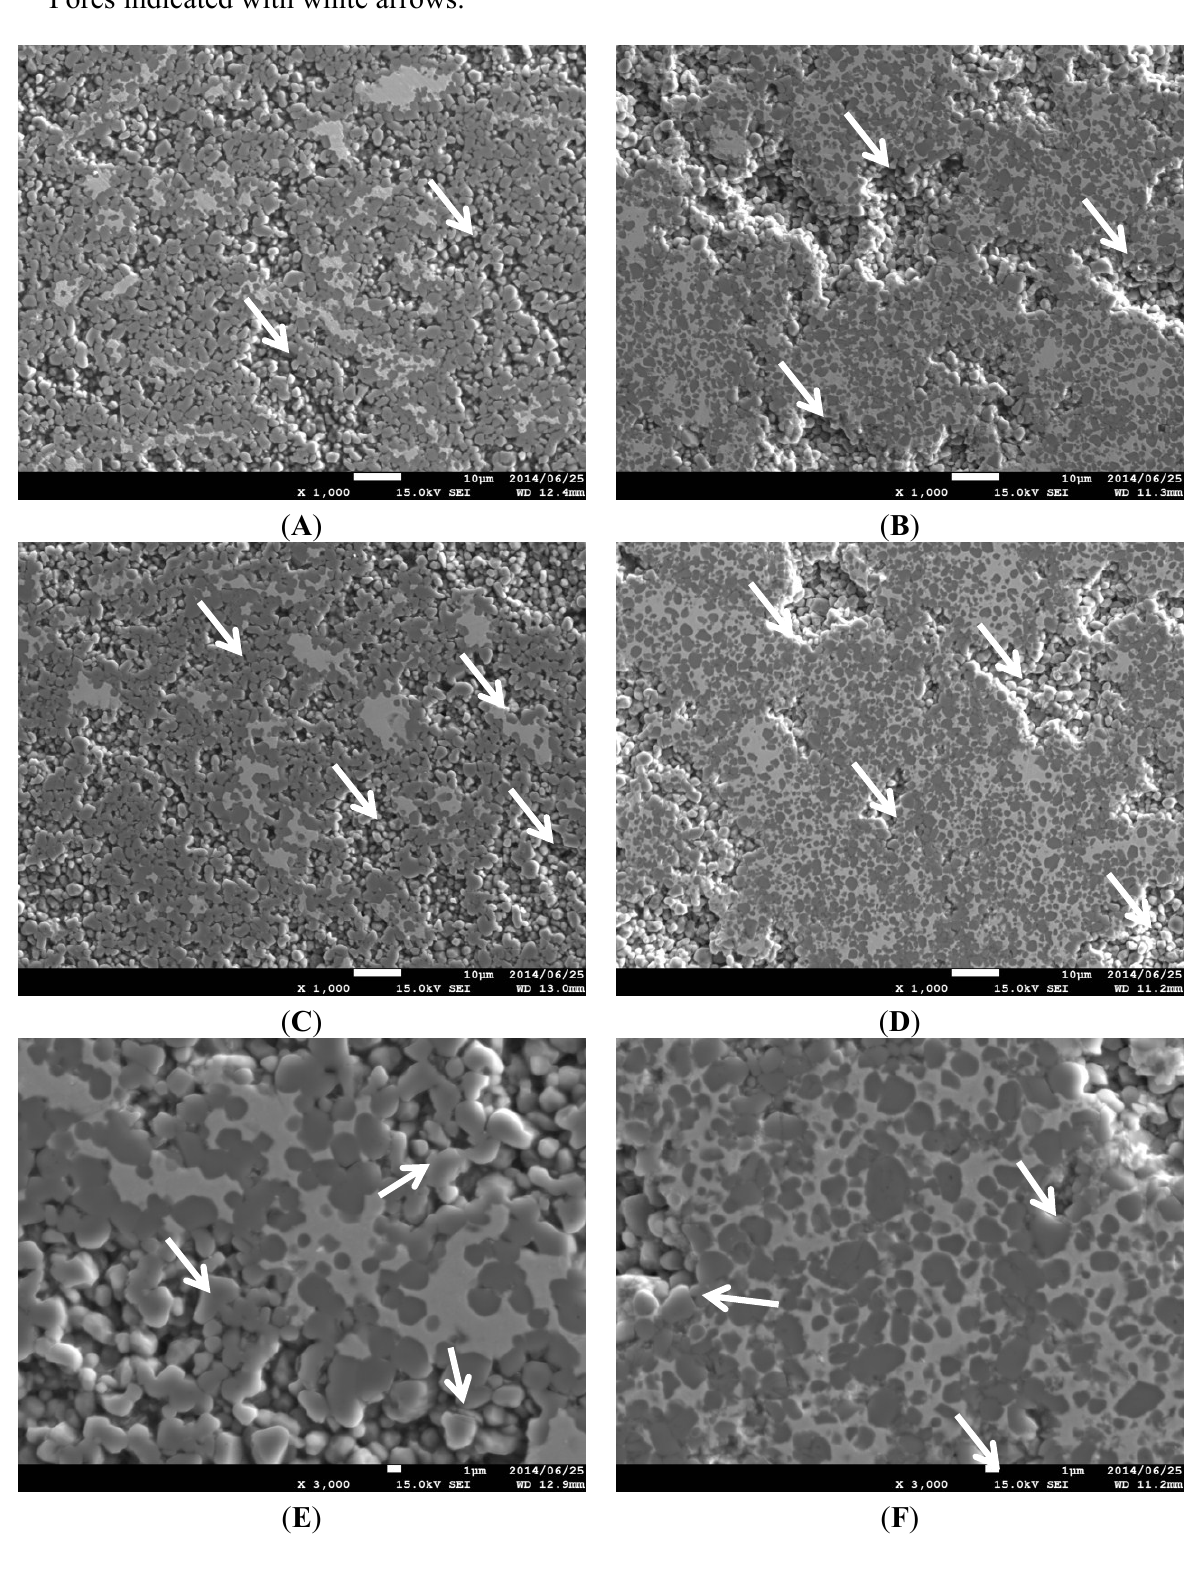
Figure 5. The scanning electron image (SEI) of TiB 2 -Cu cermets sintered at various temperatures: ( A ) TiB 2 -10 vol. % Cu, SPS at 1100 °C; ( B ) TiB 2 -30 vol. % Cu, Spark Plasma Sintering (SPS) at 1100 °C; ( C , E ) TiB 2 -10 vol. % Cu (different magnification), SPS at 1200 °C; ( D , F ) TiB 2 -30 vol. % Cu (different magnification), sintered at 1200 °C. Pores indicated with white